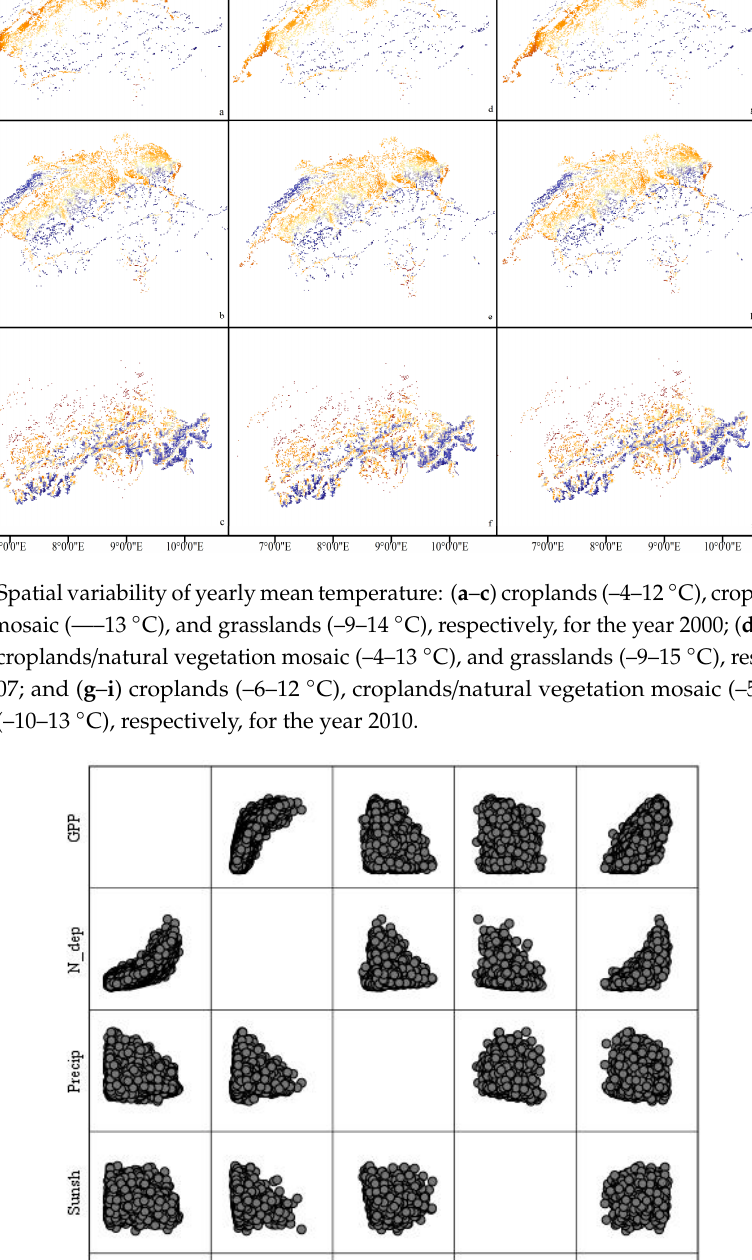
Figure A5. Correlation matrix using the original values of N deposition for the class grasslands and the year 2000.